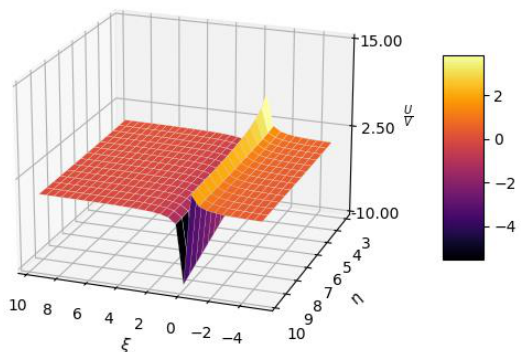
Figure 3. Three-dimensional plot representations of U / V multifractal function.